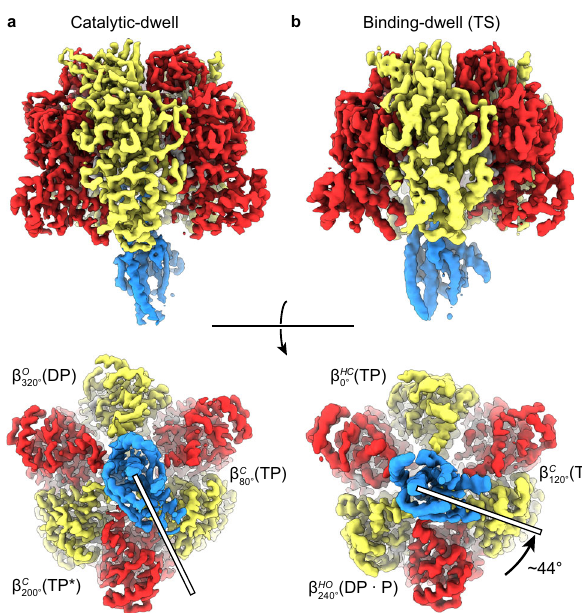
Fig. 2 Cryo-EM maps of Bacillus PS3 F 1 -ATPase in two rotational dwells. Cryo-EM maps of two rotational dwells of TF 1 ( β E190D) viewed from the side (top) and from below (bottom), with subunits colored as in Fig. 1a. a The predominant structure when imaged following the addition of 10 mM MgATP at 28 °C — the catalytic dwell. b The predominant structure when imaged following the addition of 10 mM MgATP at 10 °C — the binding- dwell (TS). Comparison of the binding dwell with the catalytic dwell indicated that between these dwells the γ -subunit rotates ~44° in the counterclockwise direction (rotation highlighted with white bars and black arrow). Overall, each dwell provided three different conformations of the F 1 - ATPase β -subunits and so provided a spectrum of the six sub-states through which the enzyme passes during its hydrolysis cycle, here termed β